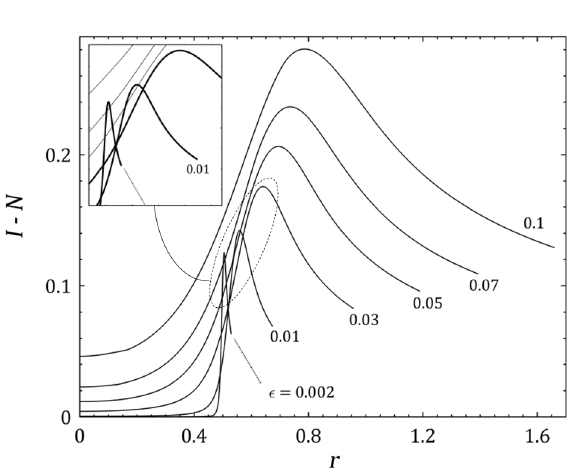
Figure 6. The full solution for the normalized electric potentil distribution φ in plasma space r for τ 5 and some values for ionization rate ǫ . α =